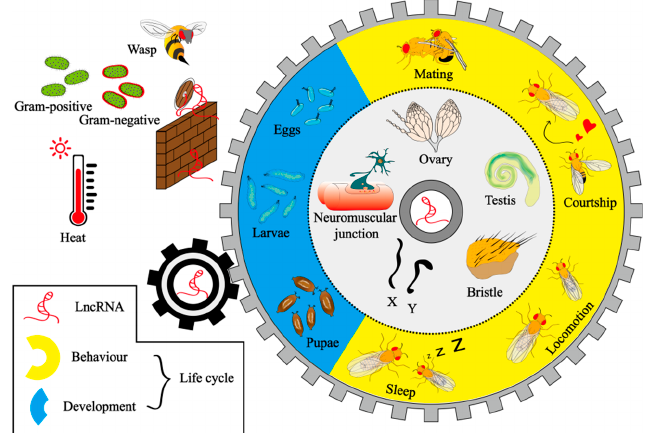
Figure 1. The biological function of long non-coding RNAs (lncRNAs) in Drosophila . LncRNAs regulate development (embryo, organ, and neuromuscular junction), behaviour (sleep, locomotion, courtship, and mating), sex determination, and dosage compensation in Drosophila . LncRNAs can also protect fruit flies from some stressors, such as heat and infection by bacteria and wasps.